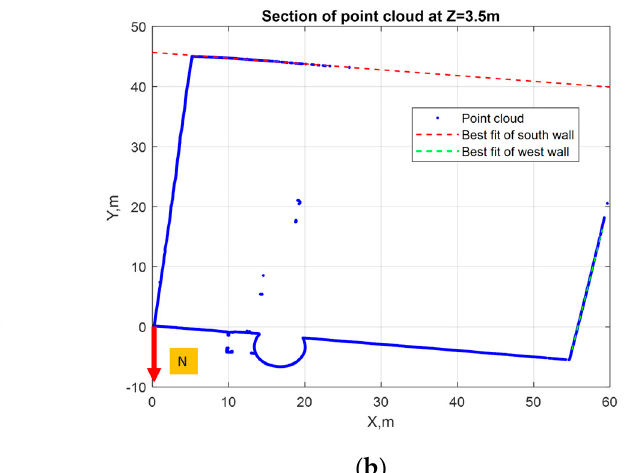
Figure 3. Estimation of the north wall’s orientation by an iPhone: ( a ) team member holds iPhone parallel to the wall; ( b ) angle measured by digital compass.